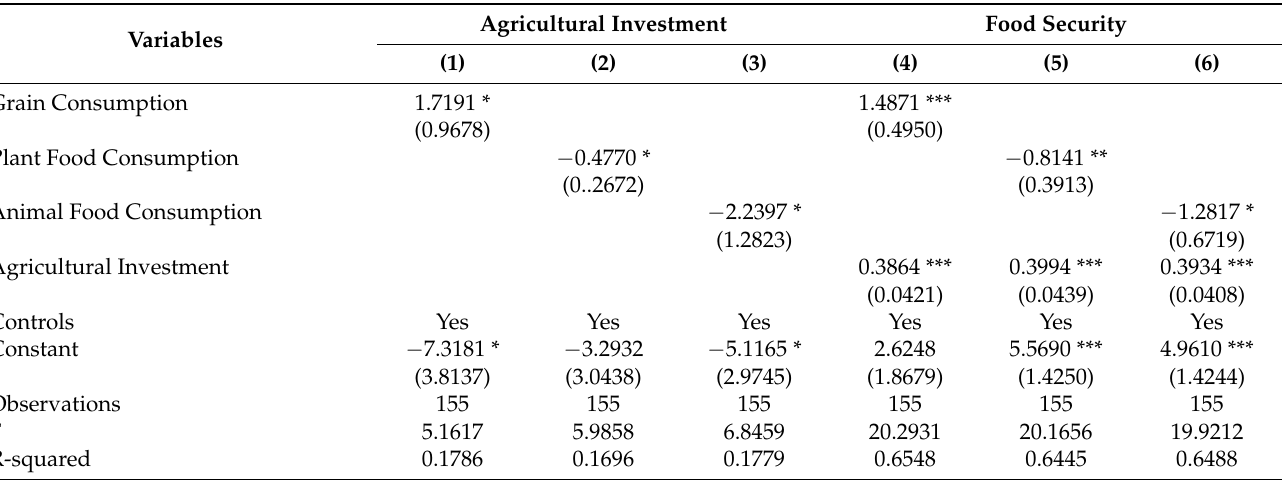
Table 7. The mediating role of agricultural investment in the impact of food consumption structure on food